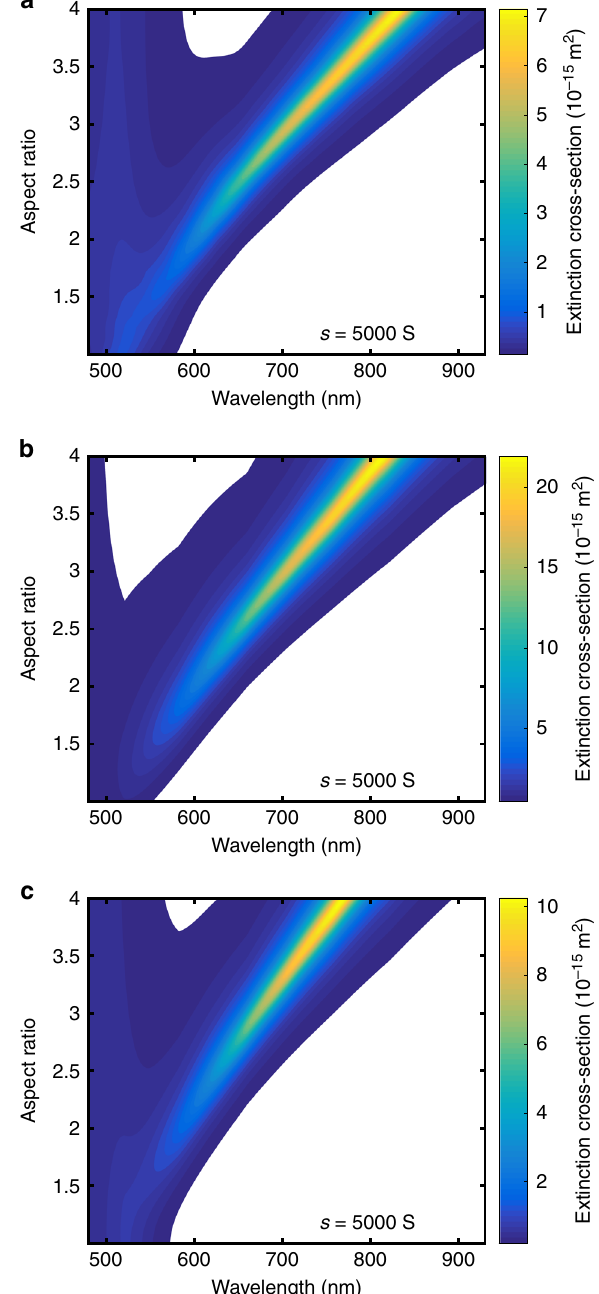
Fig. 2 In fl uence of optical modeling on simulated gold nanorod spectra. Comparison of a FEM, b LP and c Gans model for nanorods with similar sedimentation coef fi cient but varying aspect ratio. While the LP